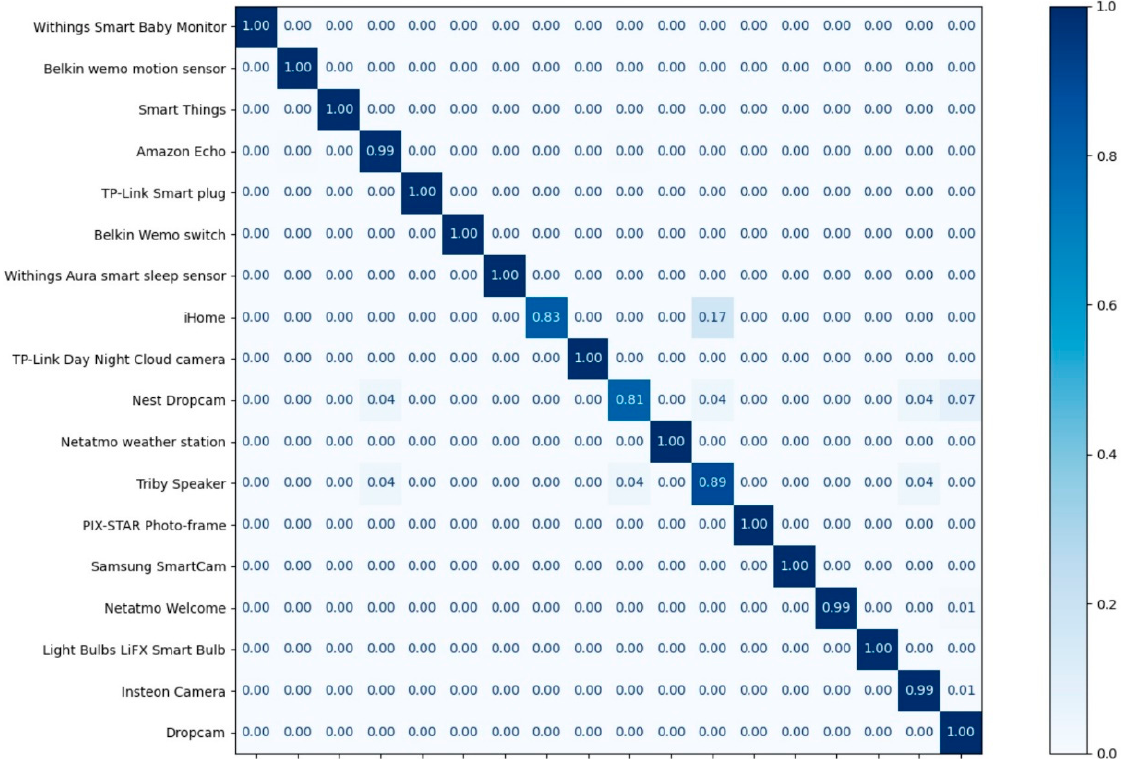
Figure 10. The confusion matrix of the classification results for the CNN.